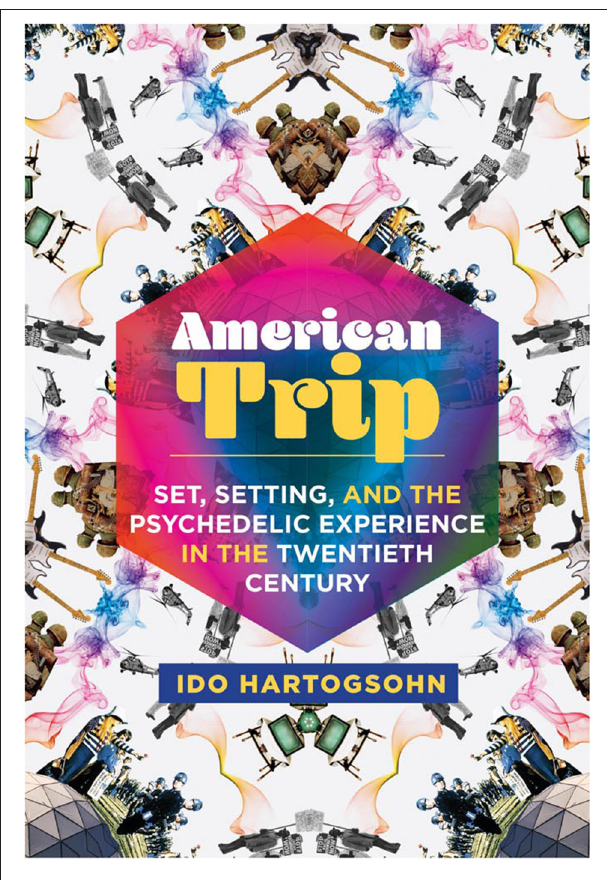
FIGURE 1 | Front cover, of American Trip by Ido Hartogsohn, MIT Press, Cambridge, Massachusetts,